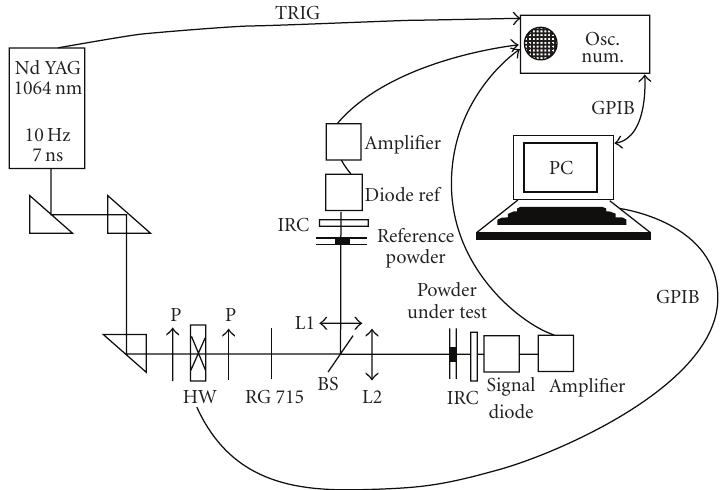
Figure 5: Kurtz-Perry powder SHG experimental setup.